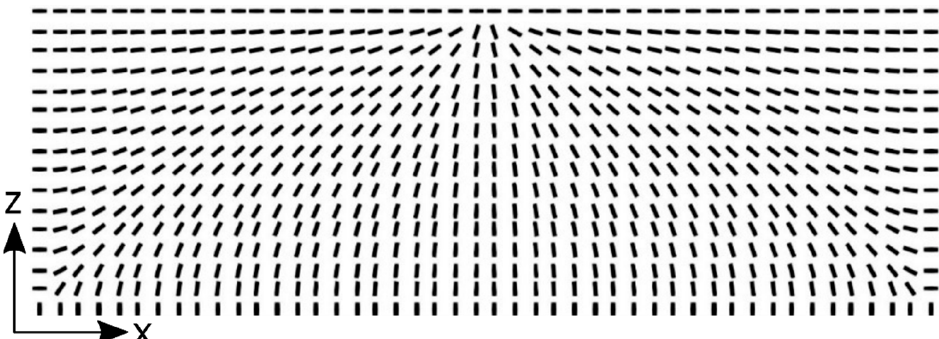
Figure 3. Steady-state hybrid configuration caused by anchoring at the bottom surface and the sides of the film before introducing the surfactant at the aqueous interface. of the film before introducing the surfactant at the aqueous